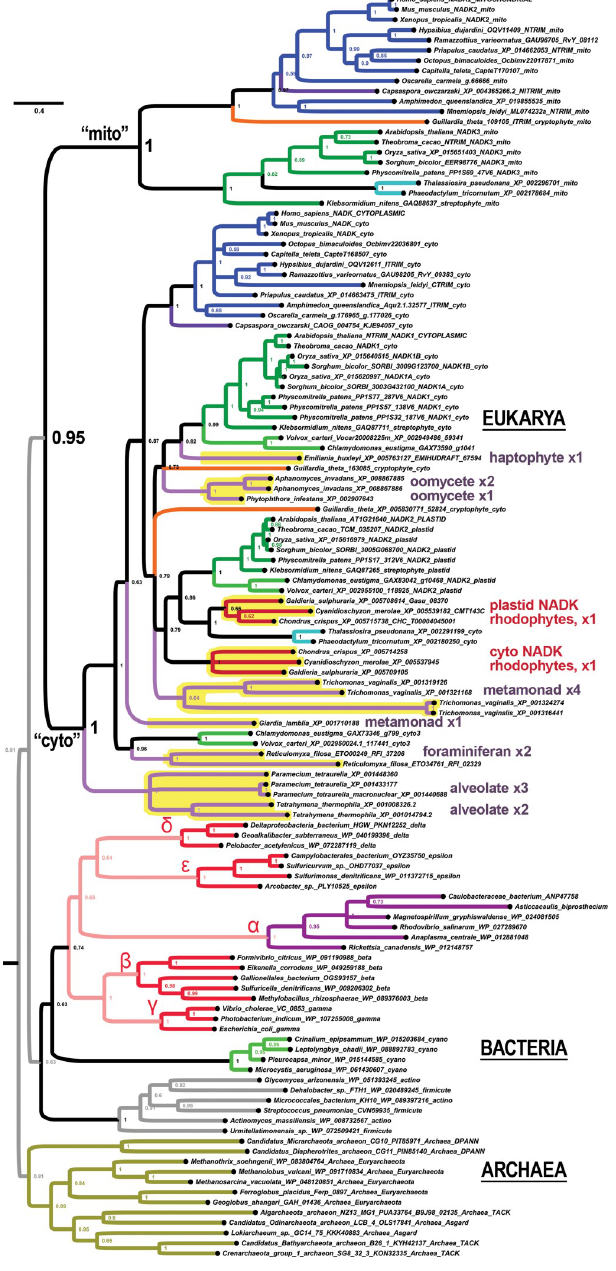
Fig 3. Many eukaryotic protists do not possess the mito-clade NADK gene of plants and animals. Unlike fungi, amoebozoans, and chlorophytes, all of which have additional NADK cyto-clade genes while missing a mito-clade NADK gene, many eukaryotic protist lineages that are also missing mito-clade NADK genes possess NADK cyto-clade genes that are only recently duplicated, if at